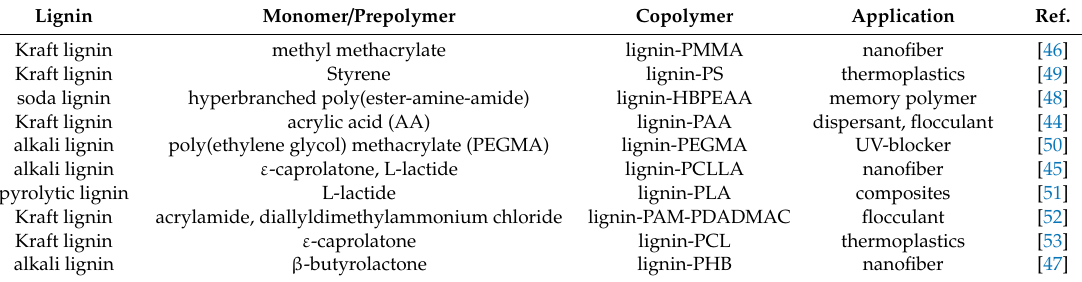
Table 1. Lignin copolymers and their